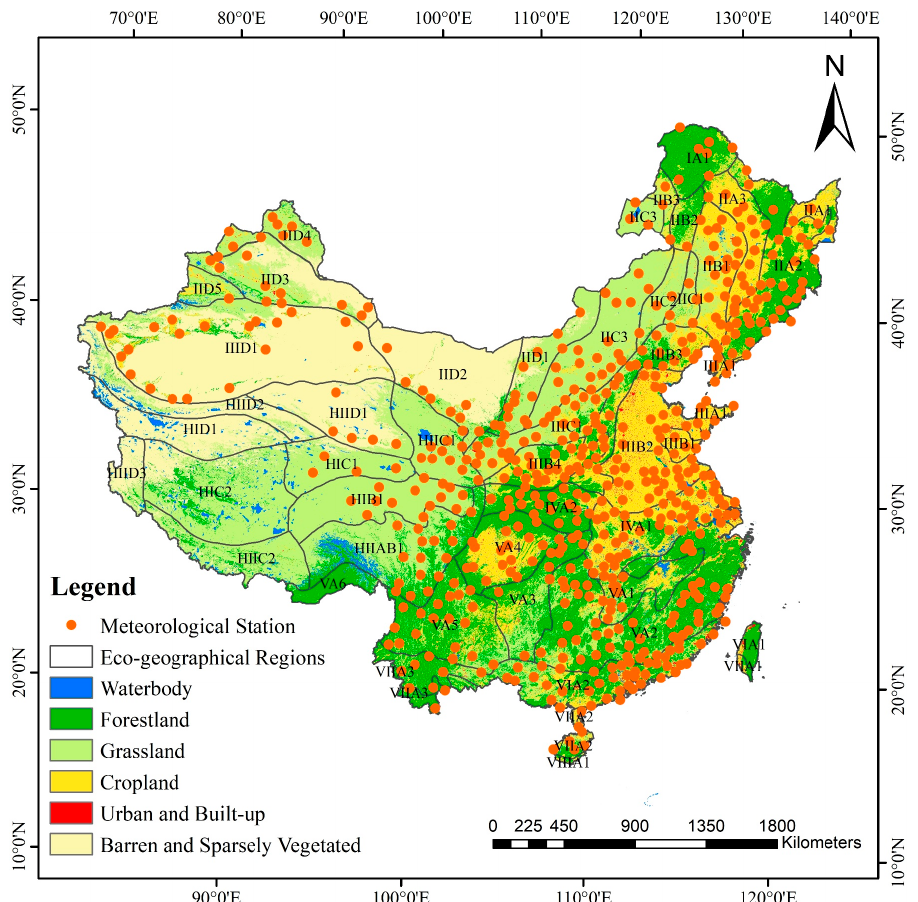
Figure 1. Distribution of eco-geographical regions and meteorological stations in China. The study area does not include South China Sea islands. Because there are many barren areas in the northwest, the density of the stations is low. The labels in the figure are the codes of eco-geographical regions. In the code, the Roman numerals represent different temperature zones, the letters indicate dry–wet regions and the Arabic numbers represent different natural regions in the same temperature zones and dry–wet regions. For example, code IA1 indicates the Daxing’an Mountains, which are located in the humid region of the cool temperature zone.